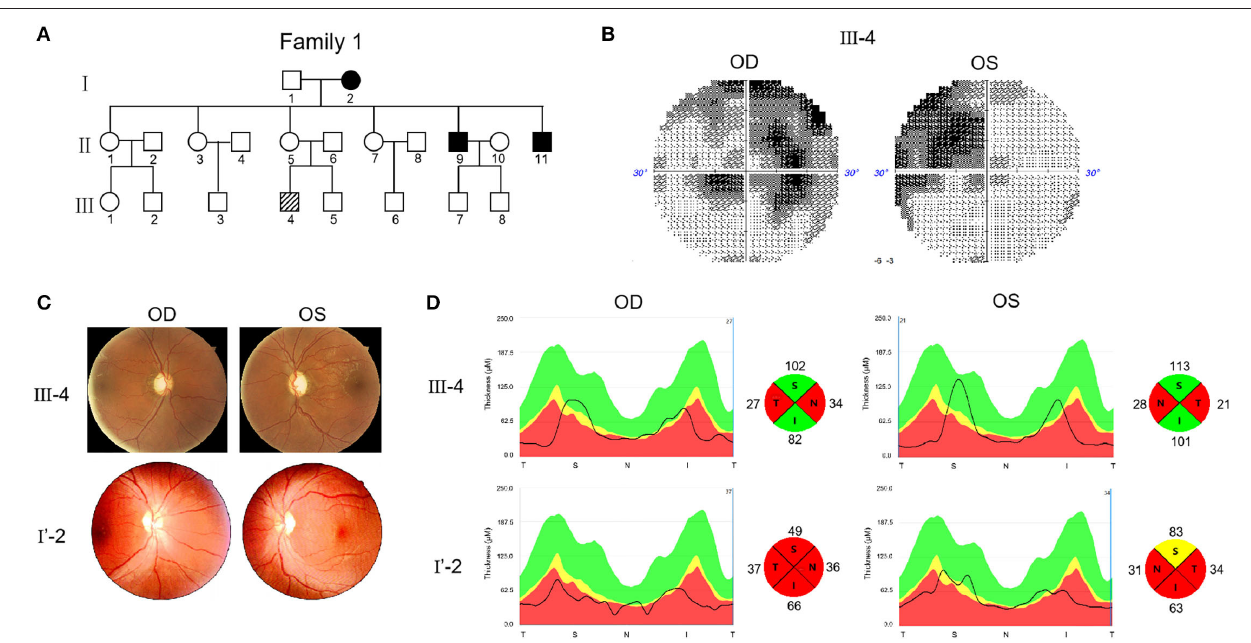
FIGURE 1 | Pedigree and features of probands with Leber’s hereditary optic neuropathy (LHON). (A) Pedigree of two probands. Arrow denotes the proband. (B) Visual field test results of proband III-4. (C) Fundus photographs of two probands. (D) RNFL assay of two probands after swept-source optical coherence tomography (SS-OCT)